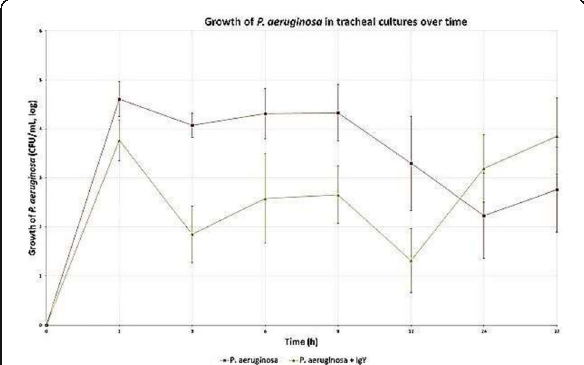
Fig. 1 (abstract 0076). Growth of P. aeruginosa in tracheal cultures over